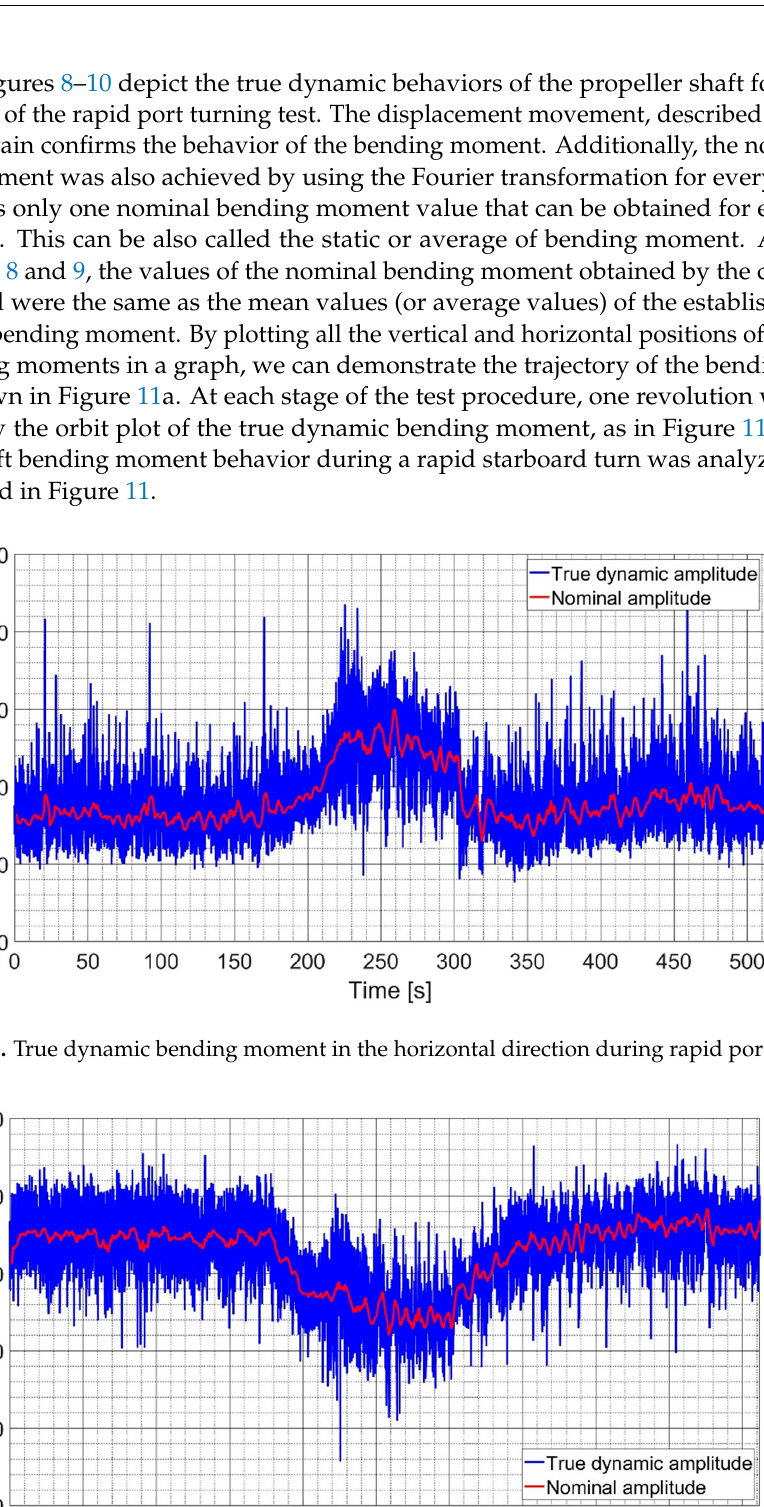
Figure 10. Displacement in vertical direction during rapid port turn. ( a ) ( b ) Figure 11. Trajectory plot of bending moment during rapid port turn. ( a ) Nominal bending moment; ( b ) True dynamic bending moment (orbit plot).